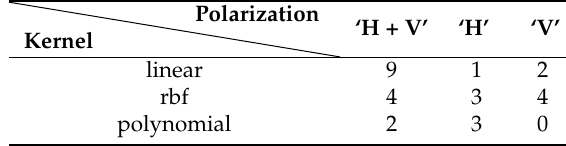
Table 6. Number of misclassified images in various conditions, for a set of 432 images in total.